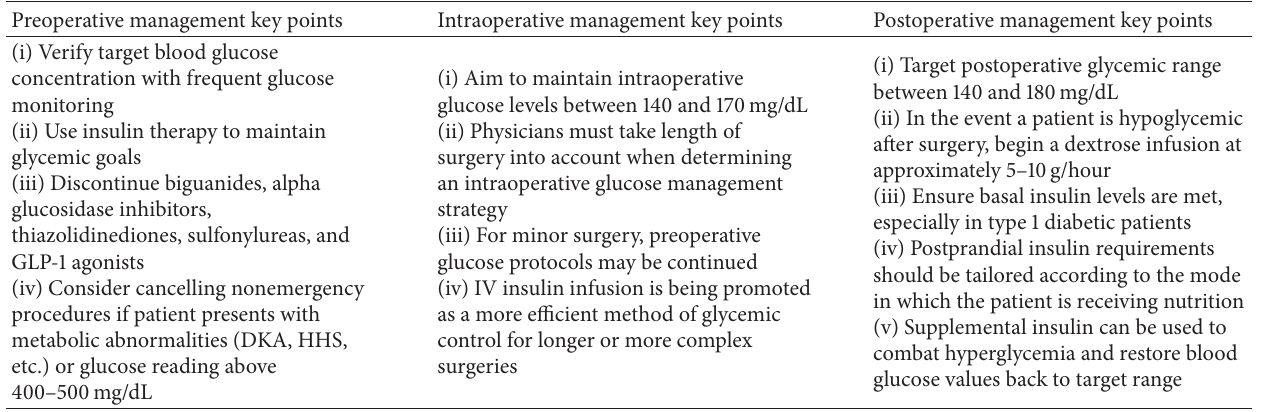
Table 1: Broad management goals across the perioperative timeline. Overall goals: (i) reduce patient morbidity and mortality, (ii) avoid clinically significant hyper- or hypoglycemia, (iii) maintain acid/base, electrolyte, and fluid balance, (iv) prevent ketoacidosis, and (v)